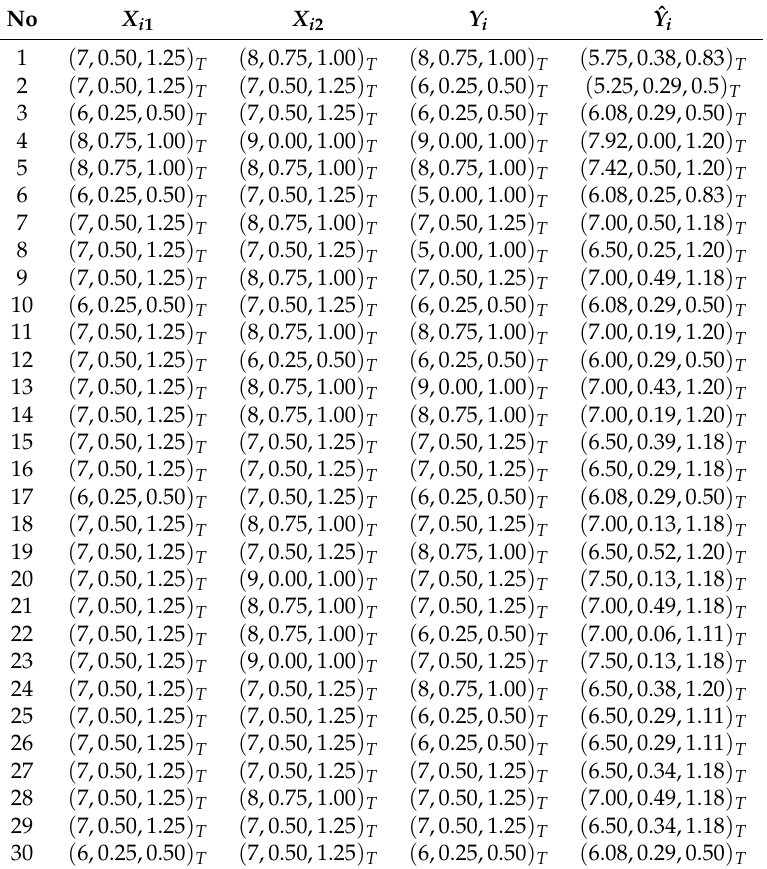
Table 1. Fuzzy observed value and predicted